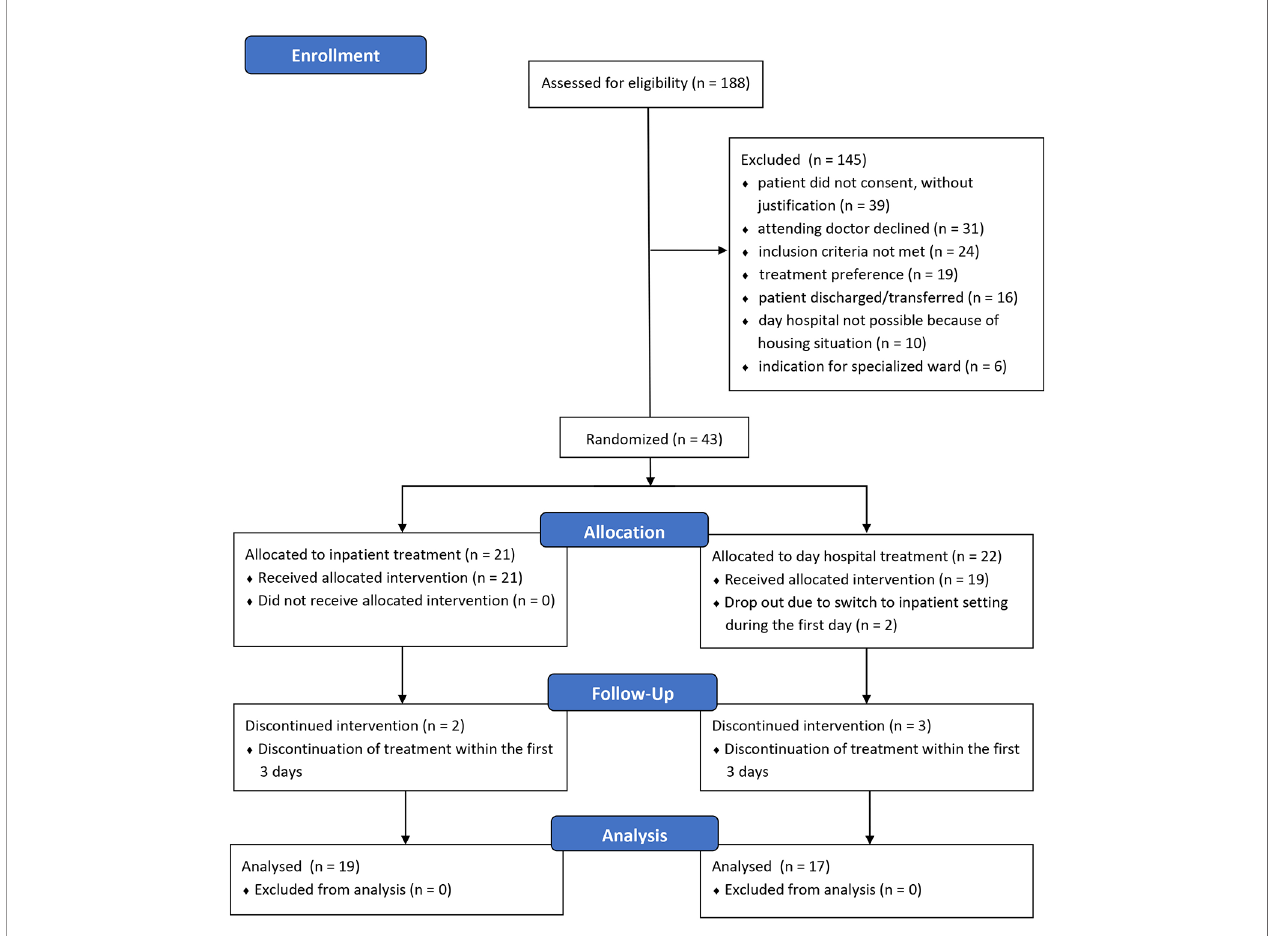
FIGURE 1 | Recruitment of the study sample and randomization according to the CONSORT statement